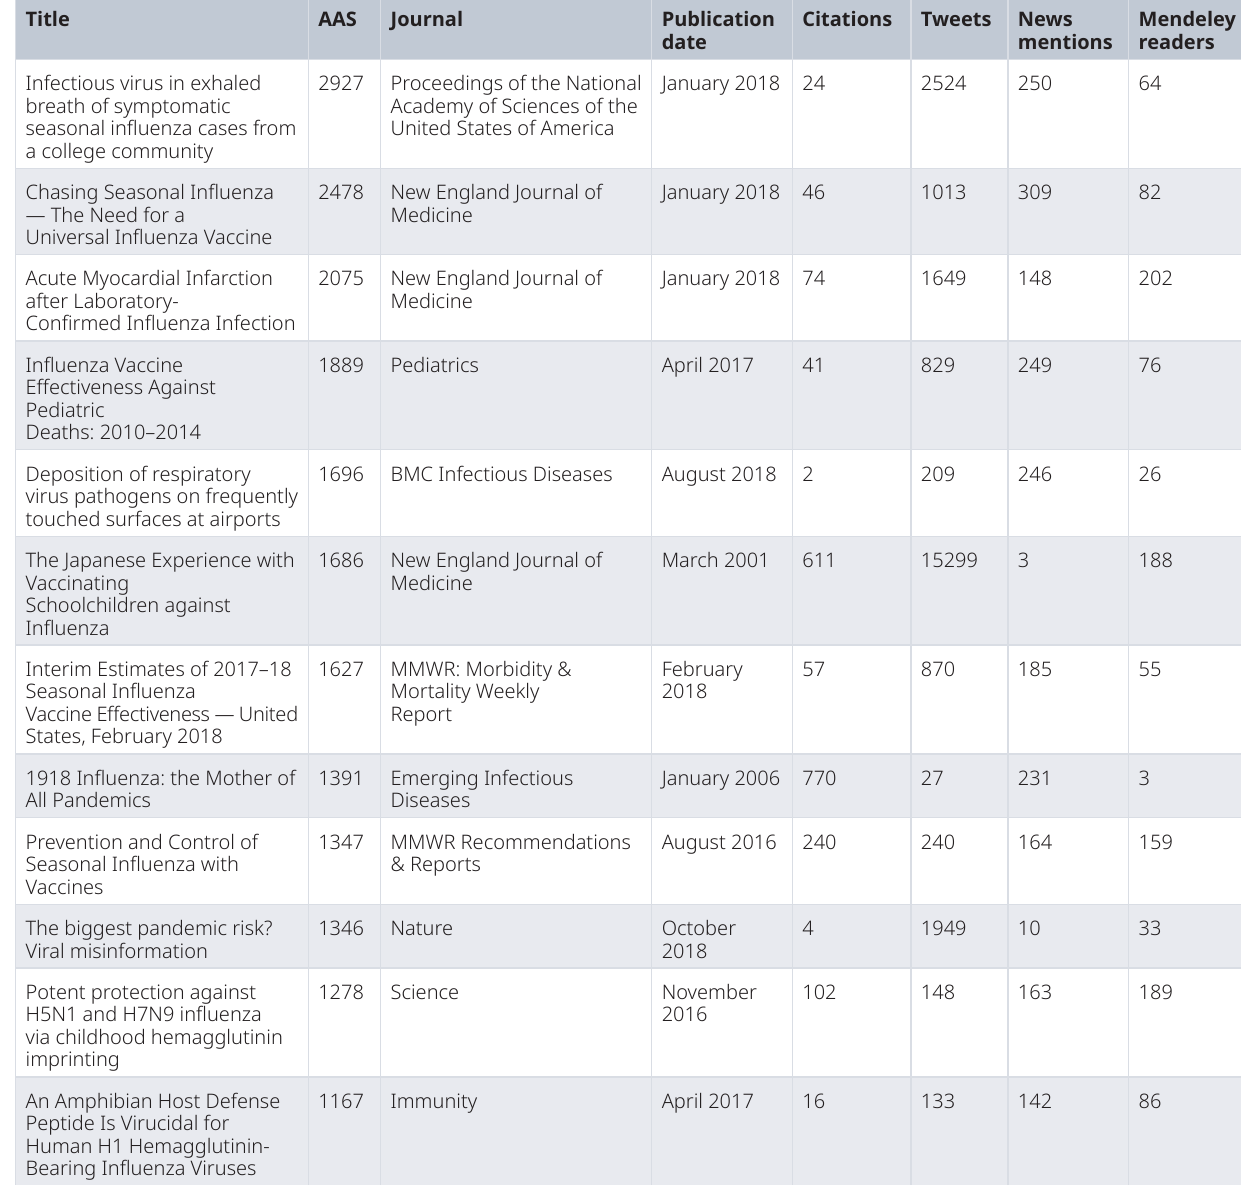
Table 3. Research outputs with an Altmetric Attention Scores (AAS) of more than 1000 discussing influenza and their respective metrics.